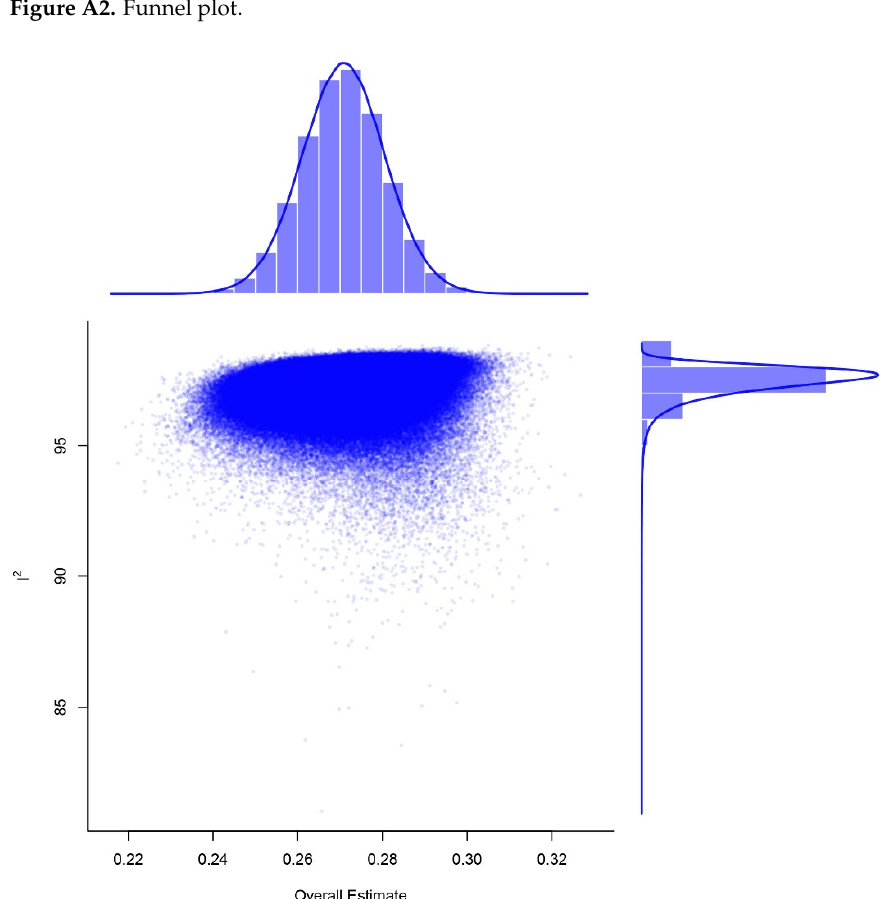
Figure A3. GOSH Figure A3. GOSH plot. Figure A3. GOSH plot.